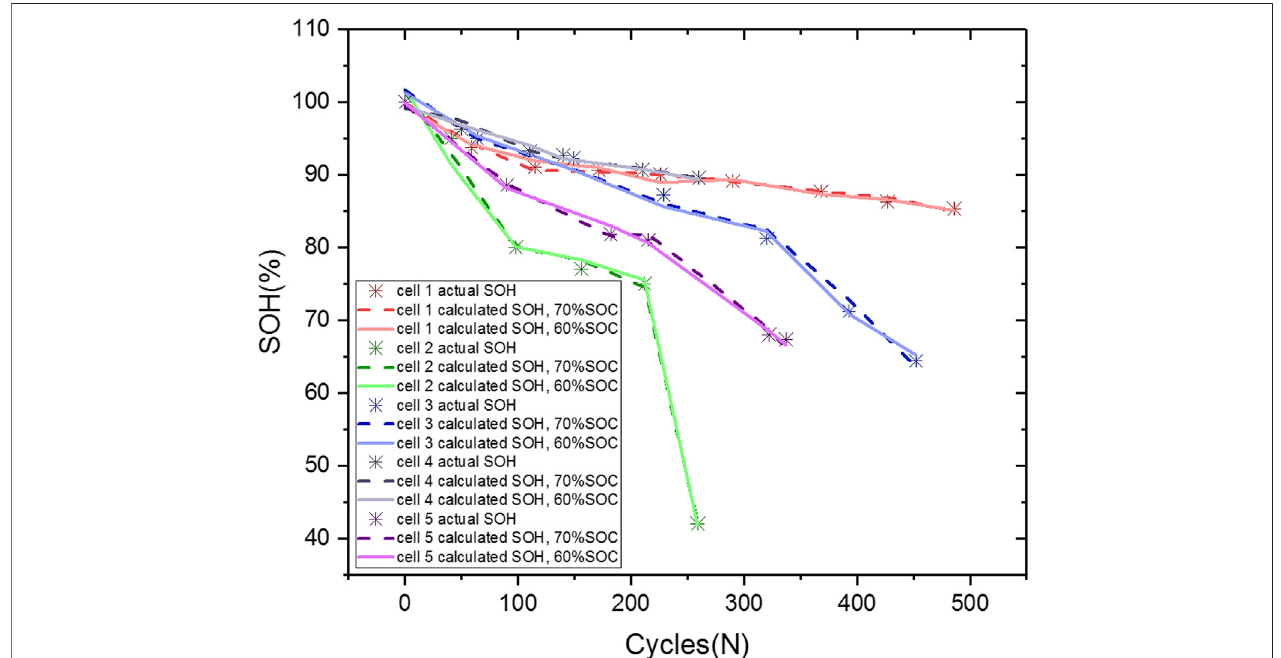
FIGURE 6 | Comparison between the calculated SOH and actual SOH.